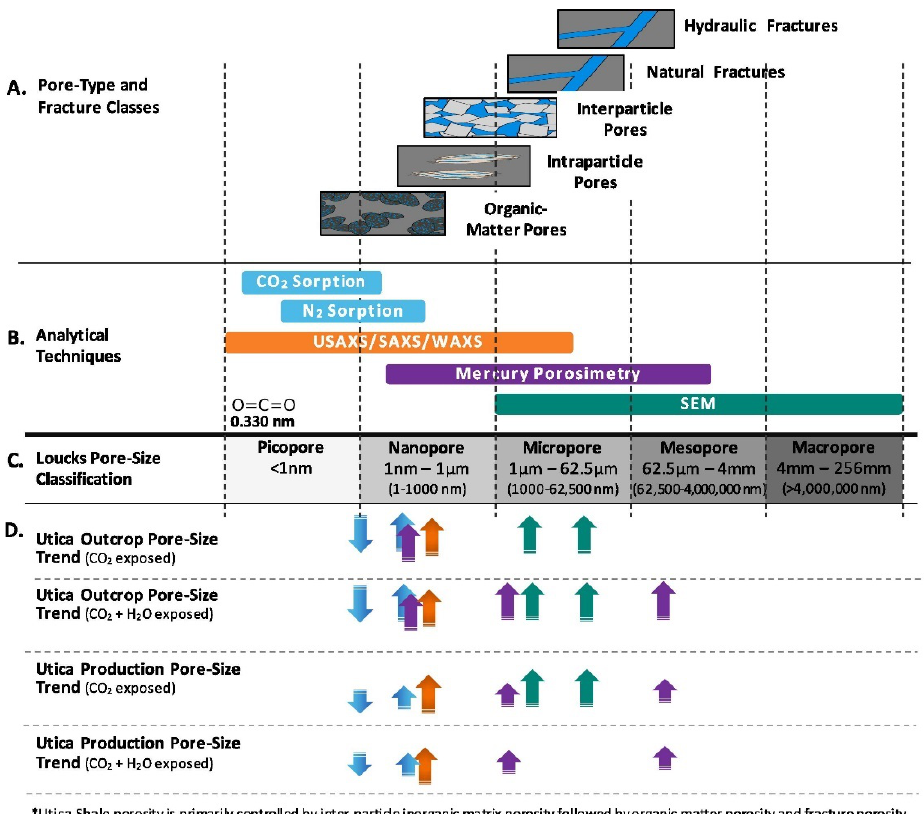
Figure 5. Schematic linking shale fracture and pore types and size classes with the analytical tech- niques applied to investigate the reactivity of Utica outcrop and production samples. ( A ) Fracture and pores present within mudrock: hydraulic fractures, natural fractures, interparticle and intraparticle pores associated with the mineral matrix, and organic-matter pores associated with the organic matrix. ( B ) Analytical techniques used to examine pore size distributions and porosity characteristics in mudrocks. ( C ) Pore size classification developed by Loucks et al. [52]. ( D ) Pore size trends with Utica outcrop and production samples following reaction with CO 2 and H 2 O. Green arrows represent data from scanning electron microscopy, blue arrows represent data from CO 2 and N 2 low-pressure gas sorption isotherm measurements, purple arrows represent data from mercury intrusion porosimetry measurements, and orange arrows represent data from X-ray scattering methods. Reprinted from Goodman et al. [25]. Copyright (2020), with permission from Elsevier.